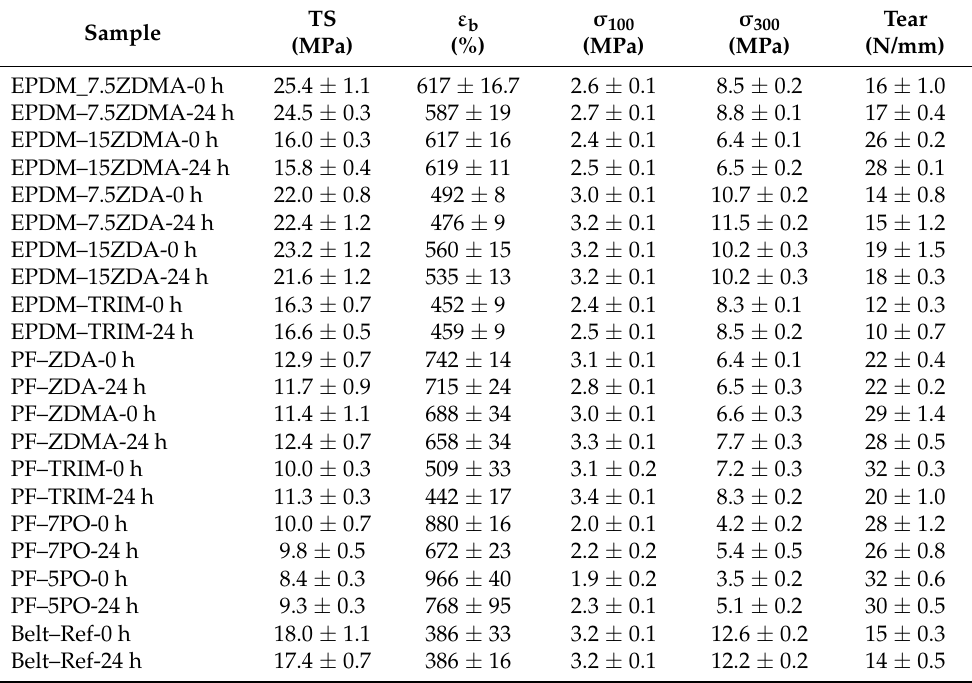
Table 5. Mechanical properties of reinforced EPDM compounds under investigation.